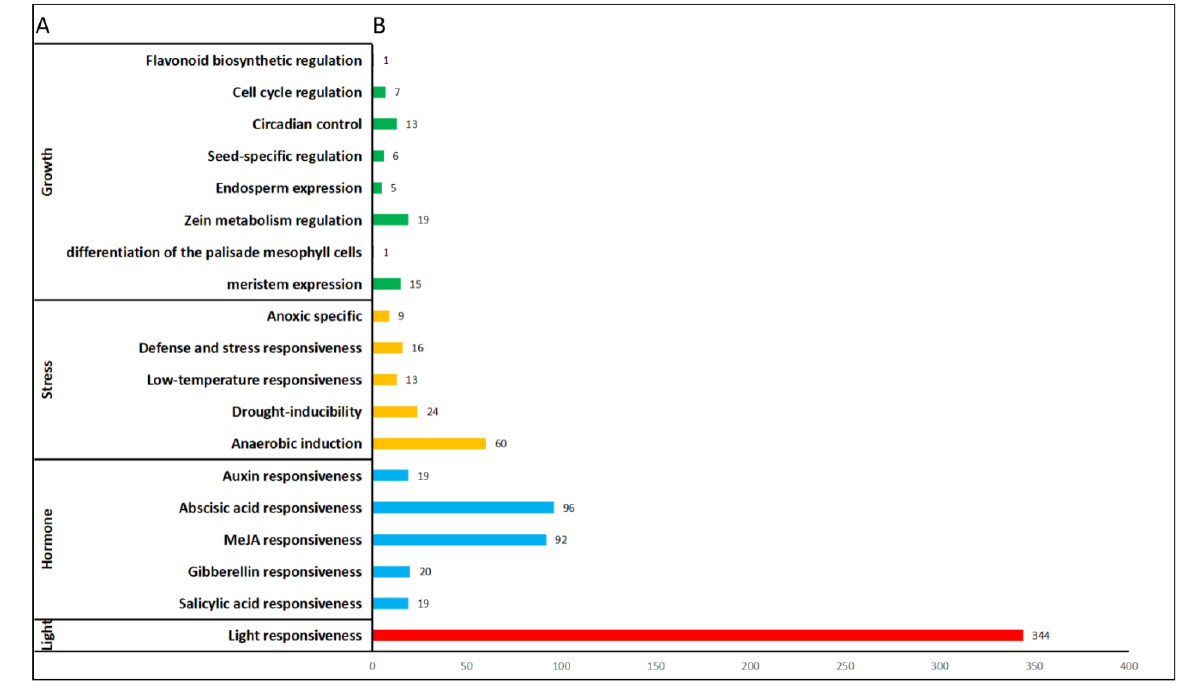
Figure 5. Statistics and classification of the cis-acting elements of PmNF-Y . ( A ) The cis-acting elements in the 2000 bp region upstream of PmNF-Y were divided into four groups according to their function. ( B ) The numbers of each cis-acting element of PmNF-Y .